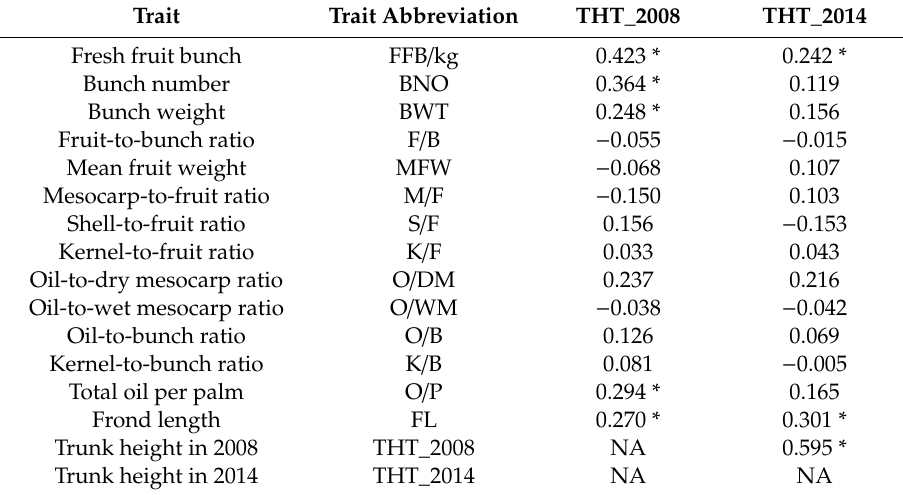
Table 1. Pearson correlation of trunk height traits, frond length and oil yield-related traits of the GM-3341 family. Trait Trait Abbreviation